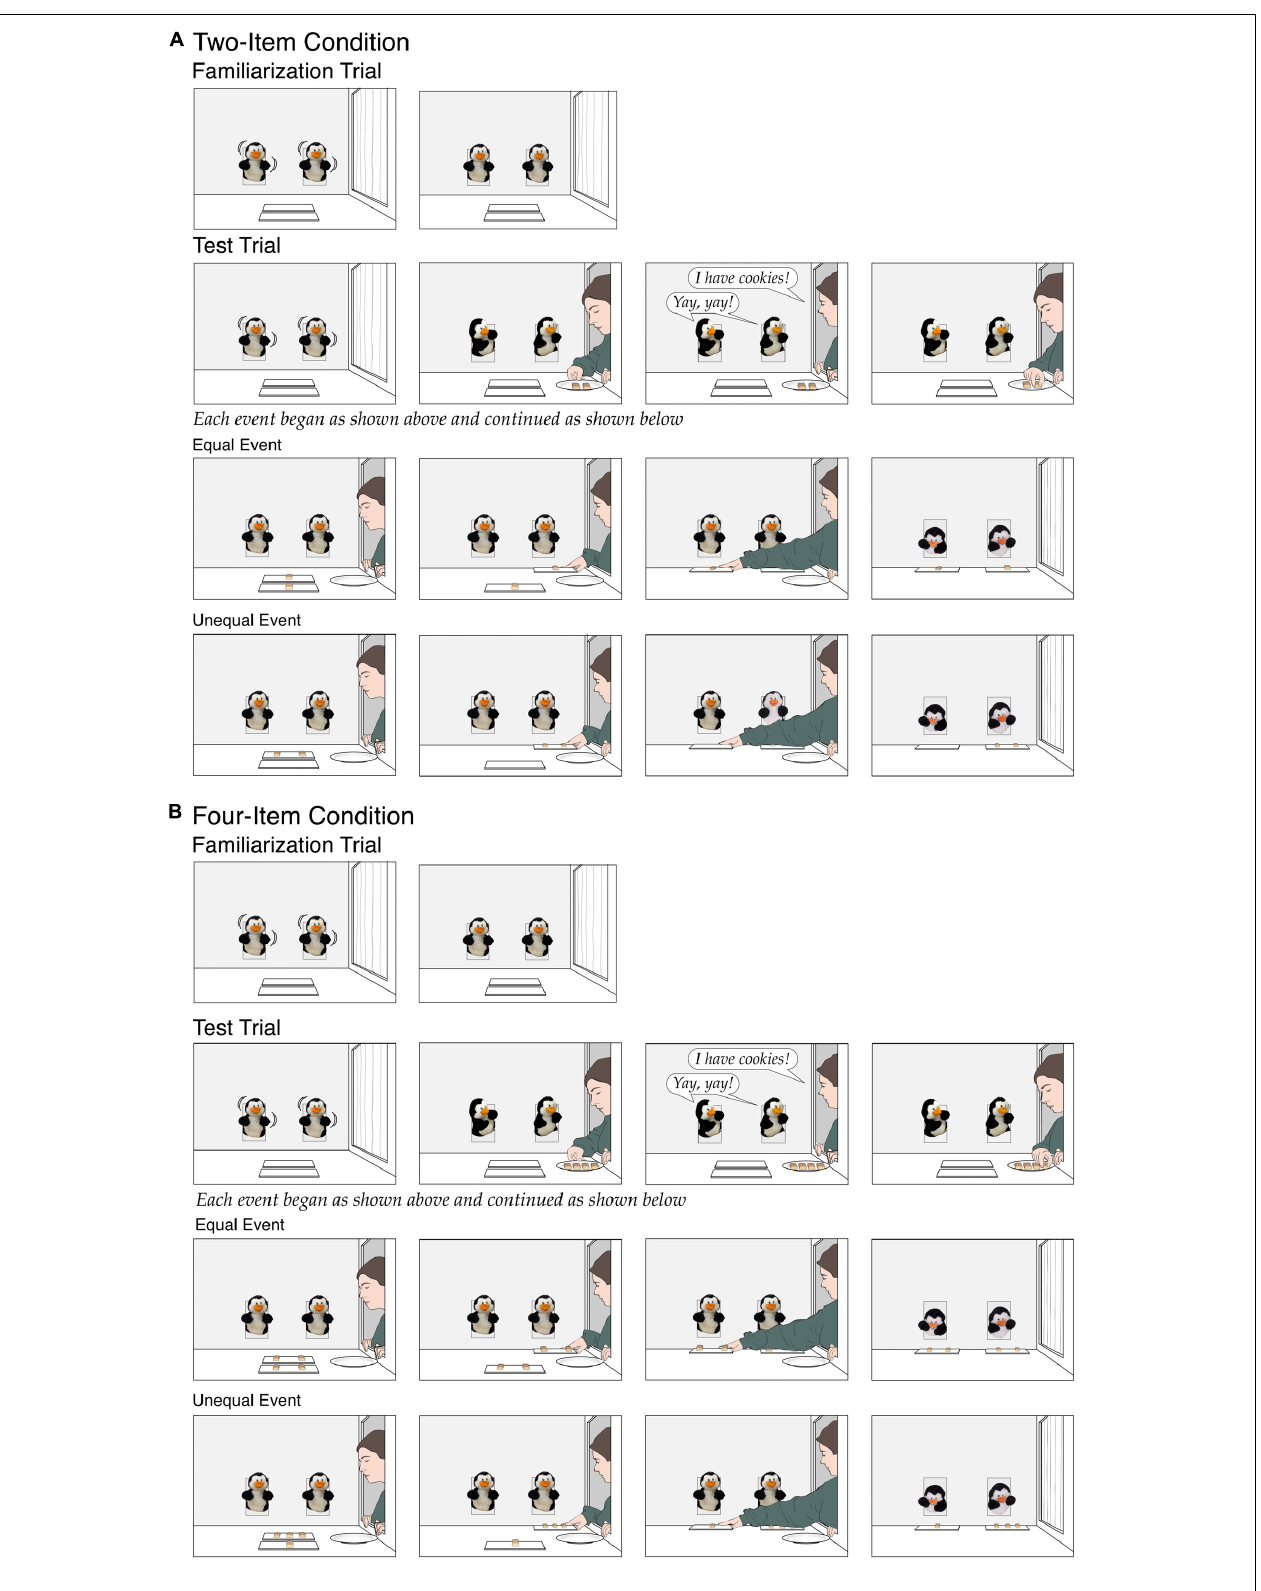
FIGURE 4 | Schematic depiction of the events shown in the two-item condition (A) and the four-item condition (B) of Experiment 3.